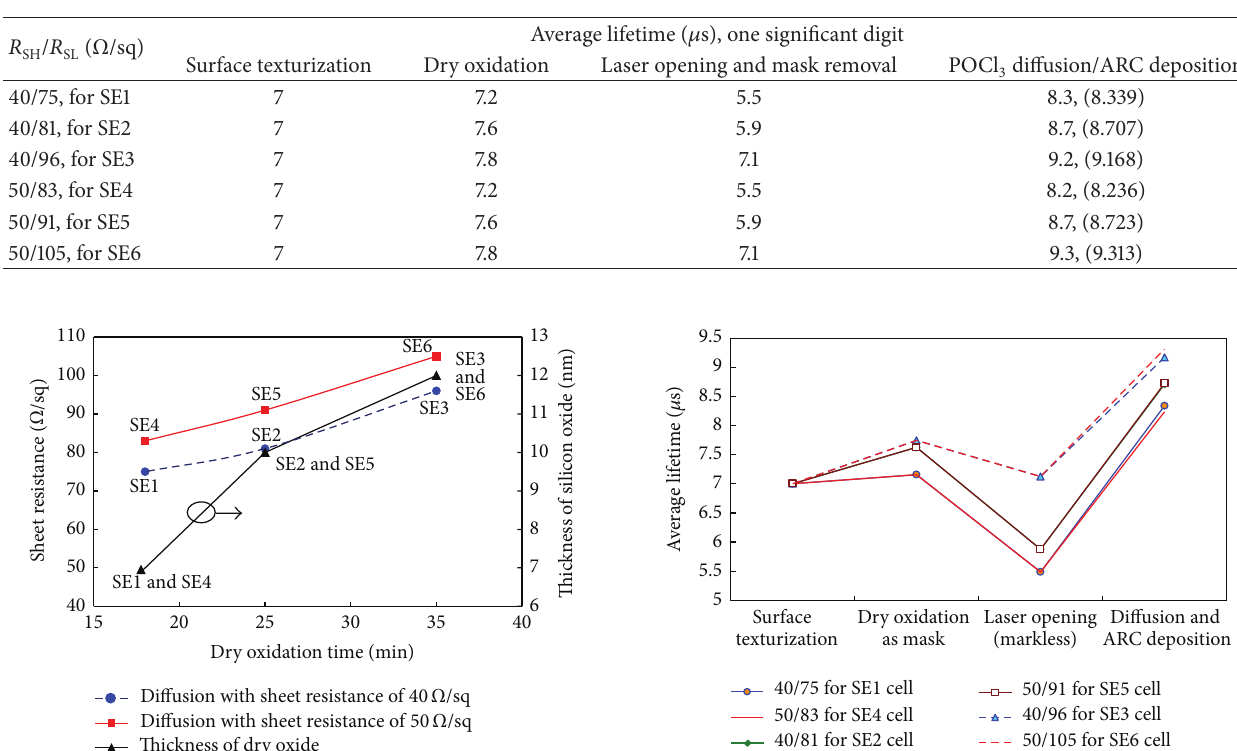
Table 1: Average lifetime of six SE samples at different check-point stages, which are surface texturization, dry oxidation, laser opening and diffusion with ARC deposition, separately. 𝑅 mask removal, and POCl 3 resistance ( Ω /sq); values inside parentheses are measured.